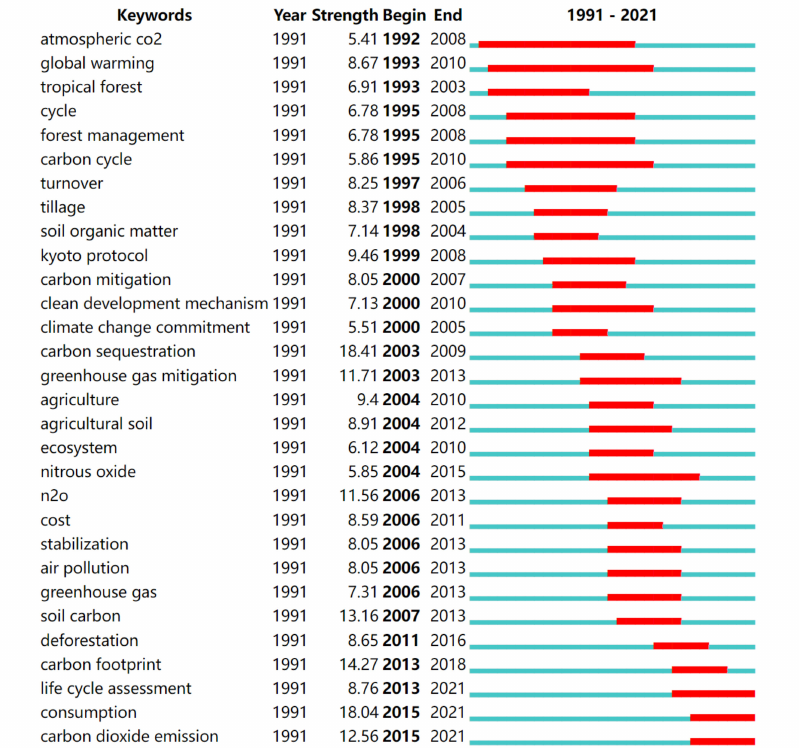
Figure 9. Key words highlighted in the first 30 citations of carbon emission reduction